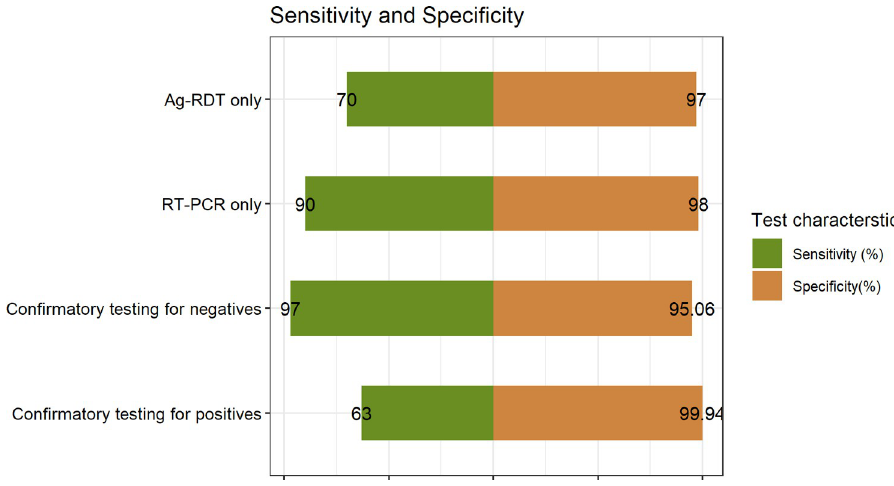
Fig 2. Sensitivity and specificity of combination testing compared with singular testing. The sensitivities and specificities of two-test algorithms are independent of the order of testing.